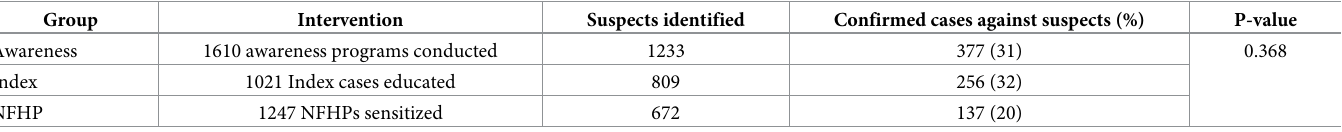
Table 1. Summary of number of cases suspected and confirmed among suspects from the three intervention areas. Group Intervention Suspects identified Confirmed cases against suspects (%)